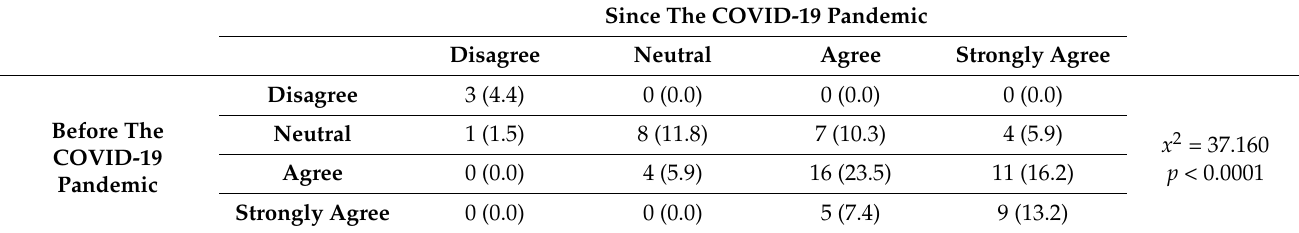
Table 3. There is enough protected time provided in the agenda(s) of GPs for reviewing guidelines or going through relevant and reliable scientific